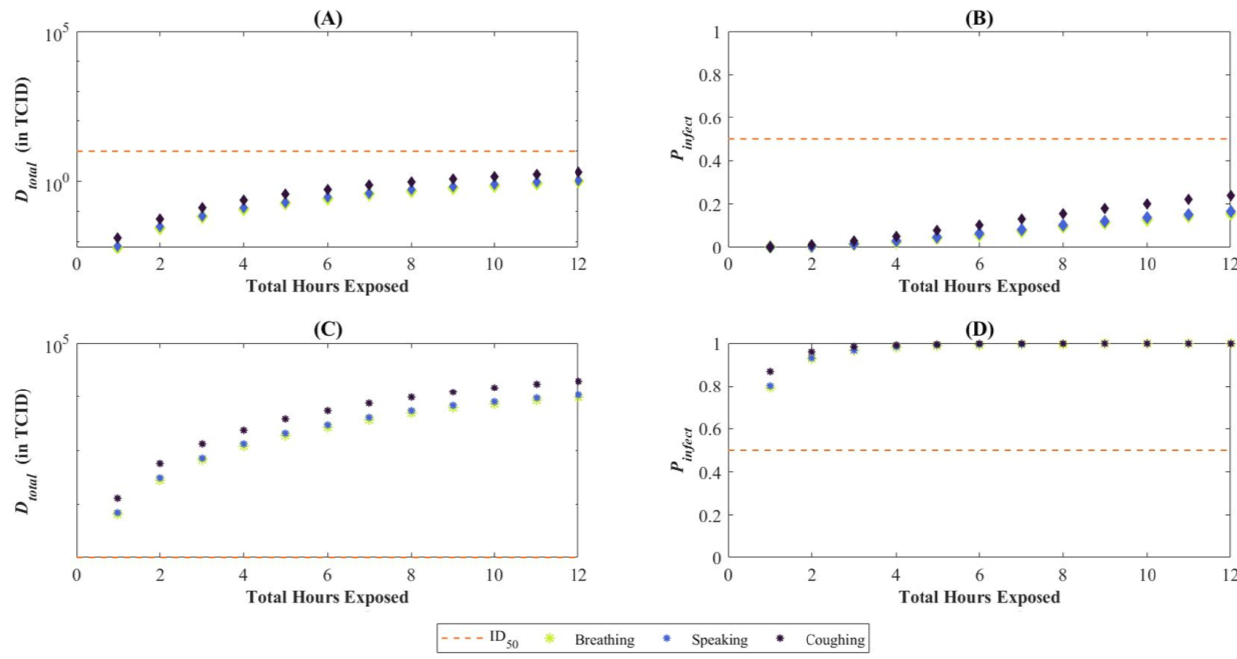
Figure 9 . Total deposited dose (D total ) and probability of infection (P infect ) for varying continuous exposure periods with ventilation turned off. The orange dashed line in each subplot represents the ID50 or 50% chance infection. Subplots ( A , B ) correspond to the median values, whereas ( C , D ) to the 95th percentile.